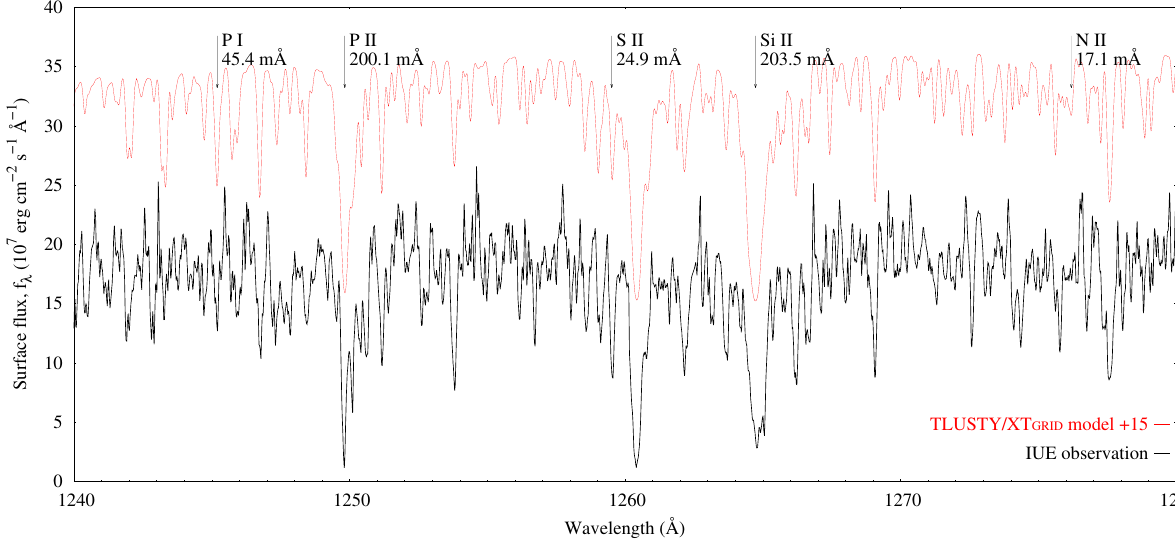
Figure 2. Part of the IUE/SWP observation of Feige86 reveals a very crowded spectrum with a wealth of heavy metal lines. However, the characteristic strong resonance lines of light metals are all remarkably weak. The strongest spectral lines that have an equivalent width larger than 10 mÅ in the 1240-1280 Å spectral range are marked for each ion. The strong lines of P correspond to a ∼ 200 times solar abun- dance, which is another indication of active atomic diffusion in